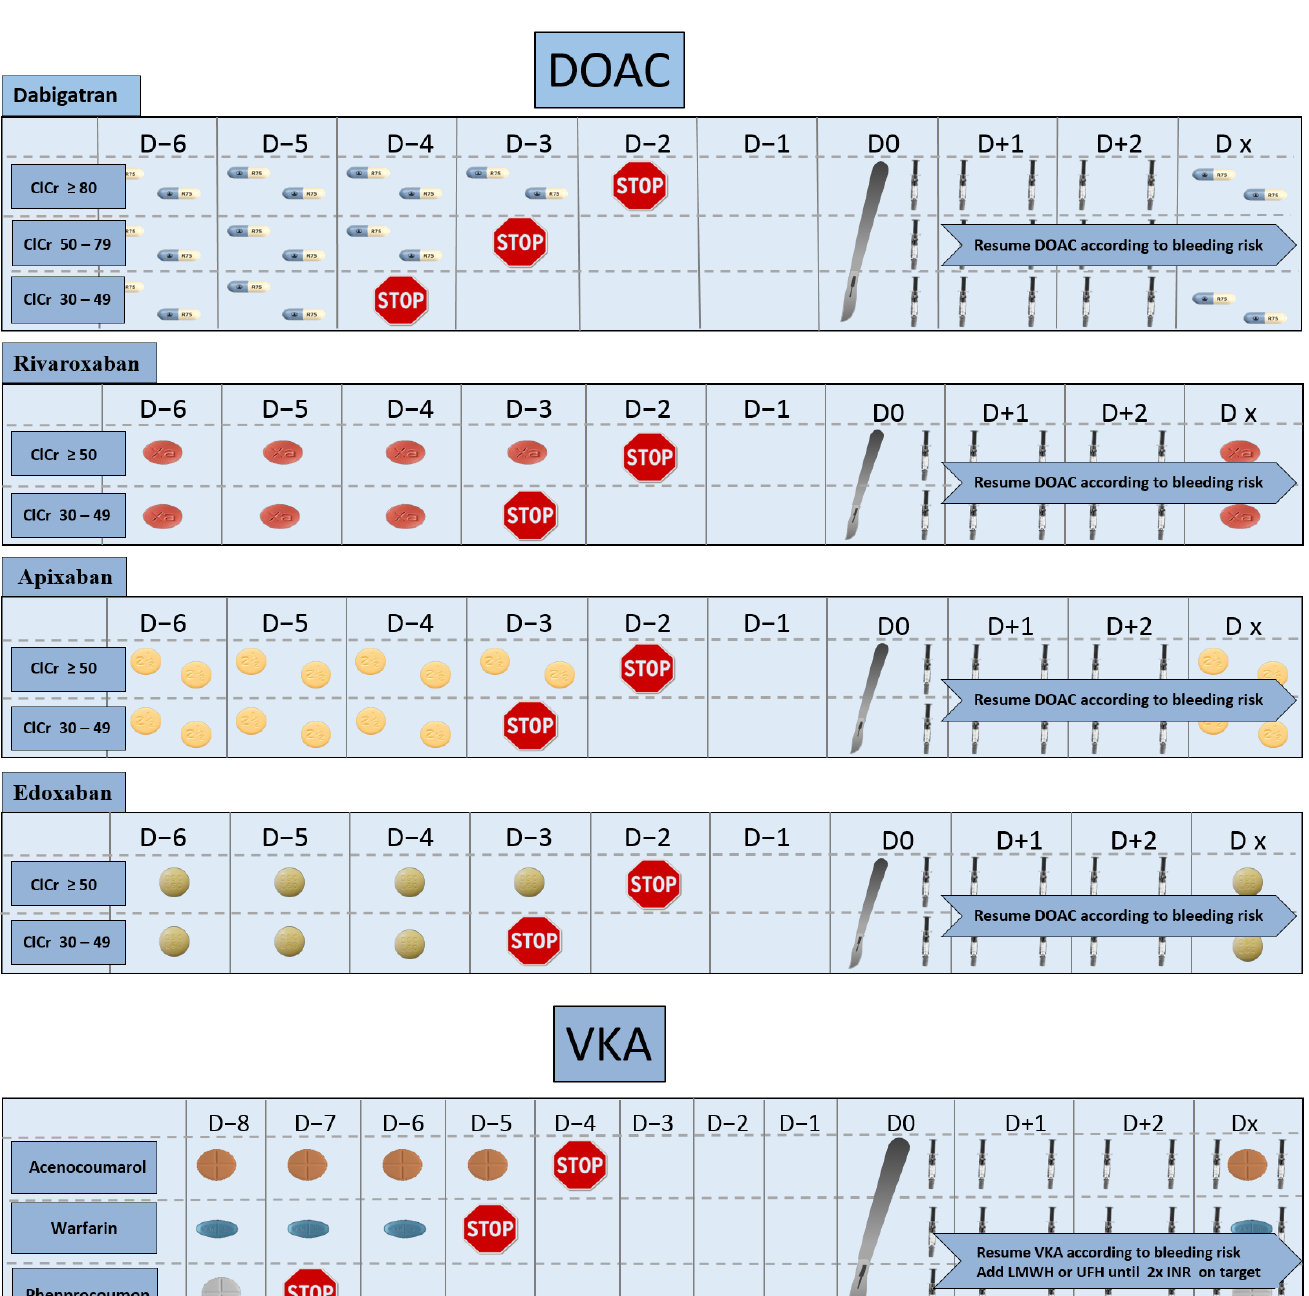
Figure 2. Our institutional scheme for management of anticoagulant medications in planned cardiac surgery. DOAC: direct oral anticoagulant, VKA: vitamin K antagonist, LMWH: low molecular weight heparin, UFH: unfractionated heparin; INR: international standardized ratio, ClCr: creatinine clearance (expressed in mL/min).